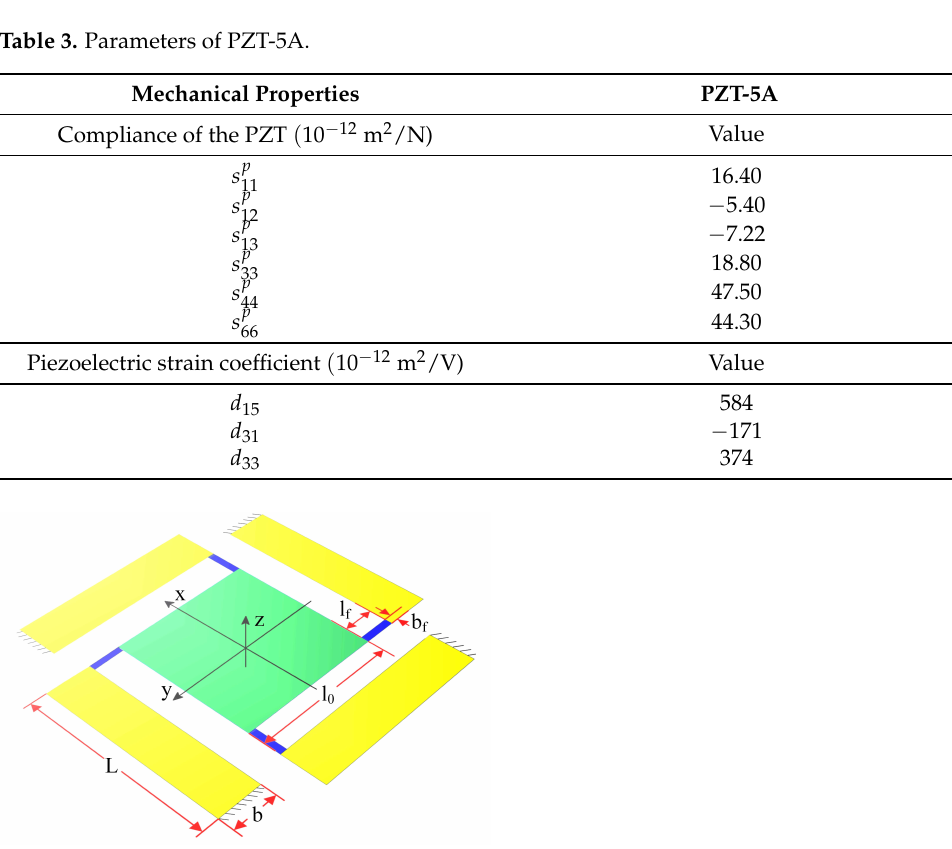
Figure 7. Structural parameters of the piezoelectric nano-positioning